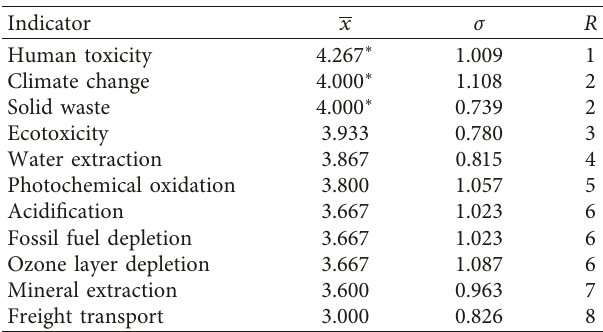
Table 3: Descriptive statistics on environmental indicators ( n �